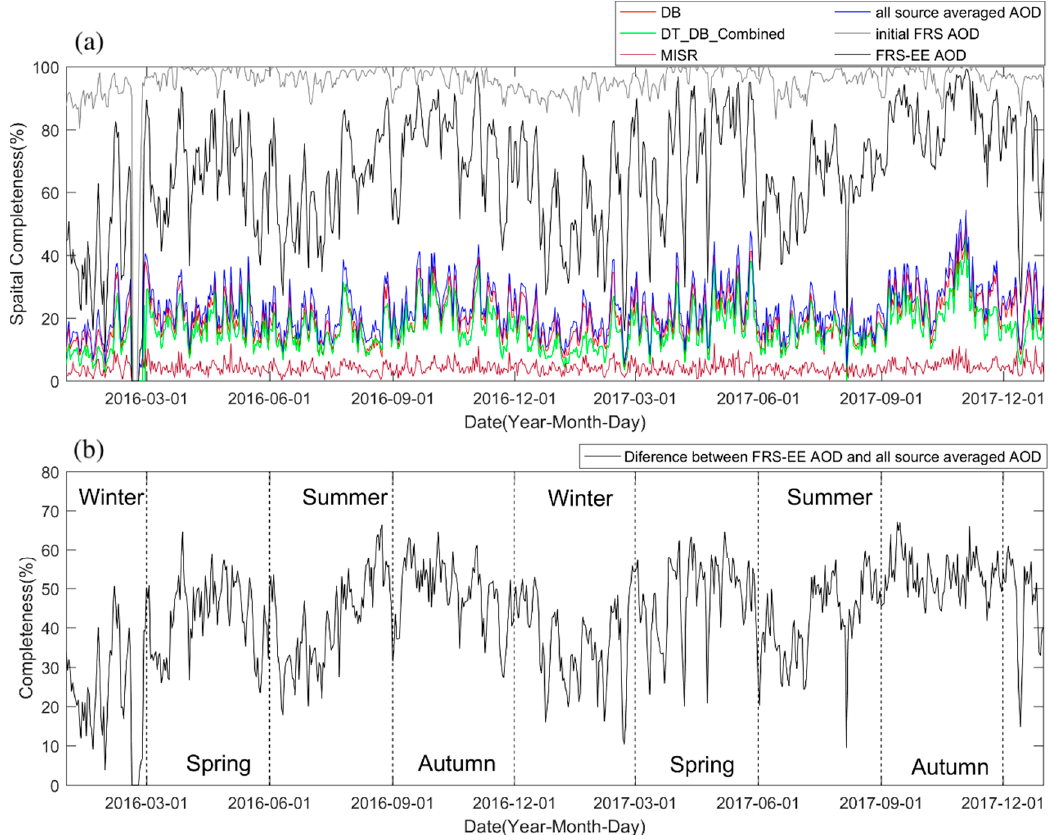
Figure 7. Spatial completeness in temporal variation. ( a ): daily spatial completeness for DB AOD, DT_DB_Combined AOD, MISR AOD, all source averaged AOD, initial FRS fused AOD, and FRS-EE fused AOD. ( b ): Spatial completeness improvement in each day. Table 2. Seasonal statistics of the spatial completeness for original, all source averaged, and FRS-EE fused AODs (unit: %). MAM: March-April-May; JJA: June-July-August; SON: September-October- November; DJF: December-January-February.